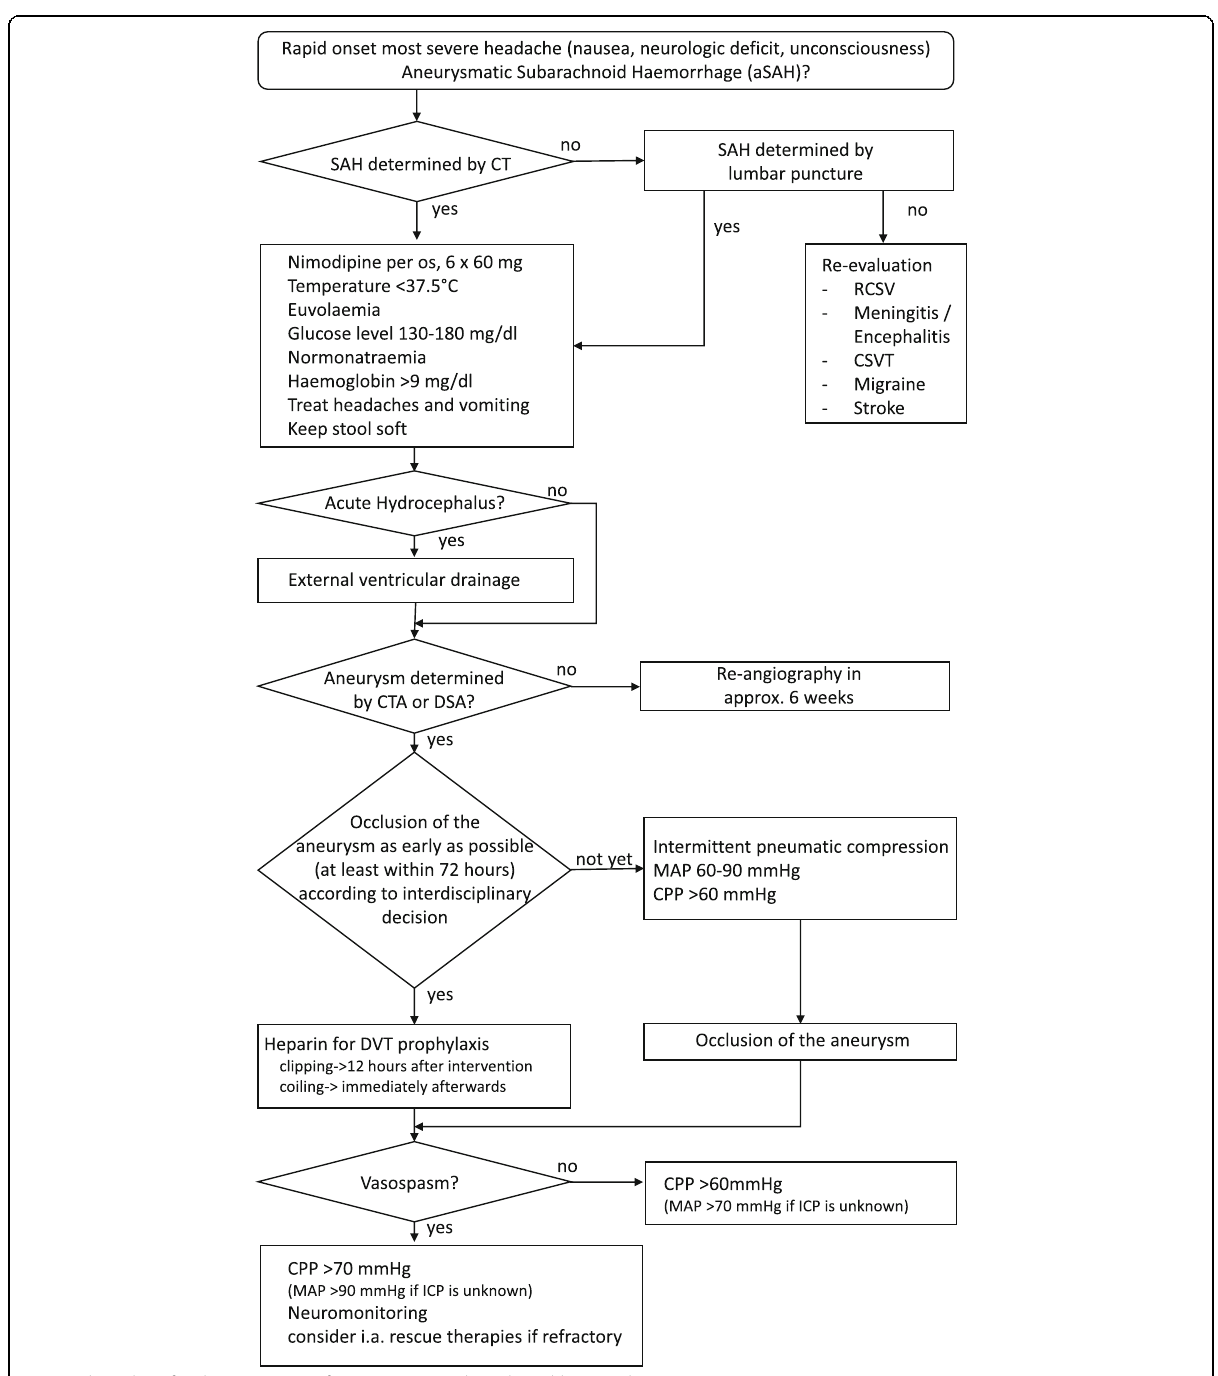
Fig. 1 Flow chart for the treatment of aneurysmatic subarachnoid